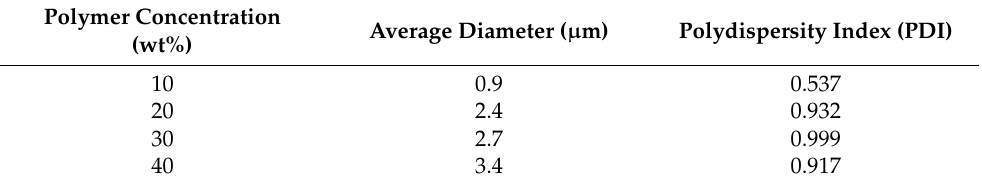
Table 1. Pore size analysis of micro emulsion-based polystyrene microsphere templates prepared at different polymer